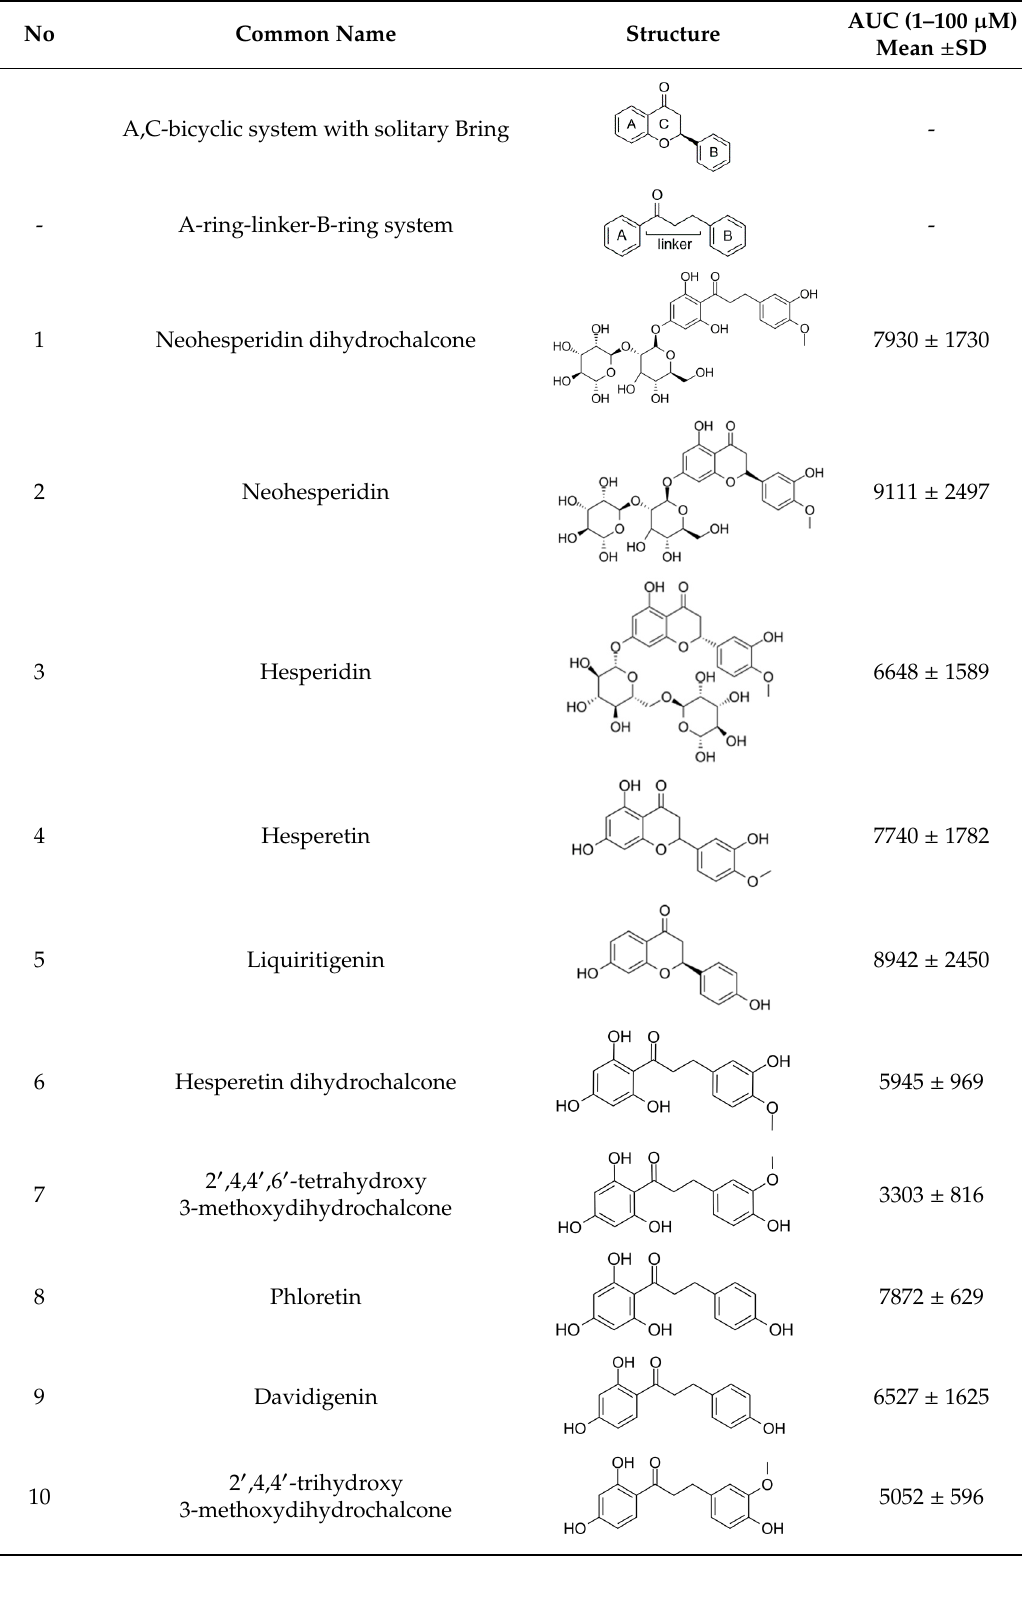
Table 1. Basic core structures with labels, numbering, common names (if applicable), structures, and calculated areas under the curve (AUCs) as the sum of trapezoid areas under the dose–response curve of interleukin-8 (IL-8) values (normalized to Porphyromonas gingivalis lipopolysaccharide ( pg LPS) control) from 1 µM to 100 µM for tested substances 1 – 18 .